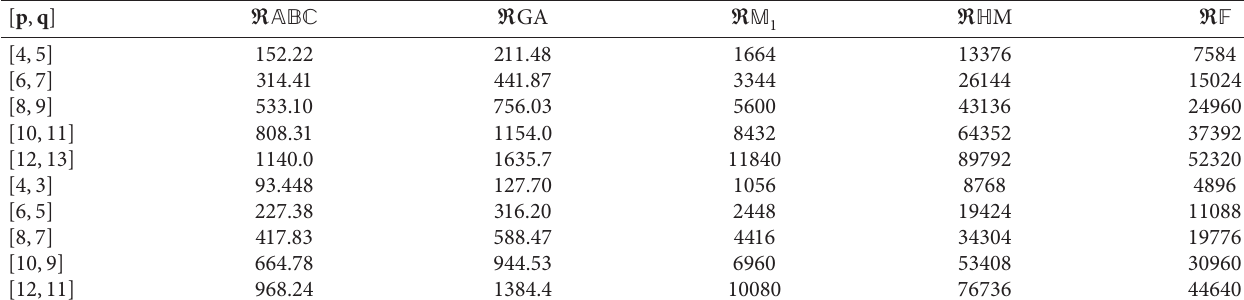
, R H M, and R F for Case 1